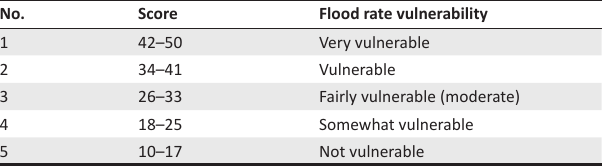
TABLE 5: Flood vulnerability rate by score.